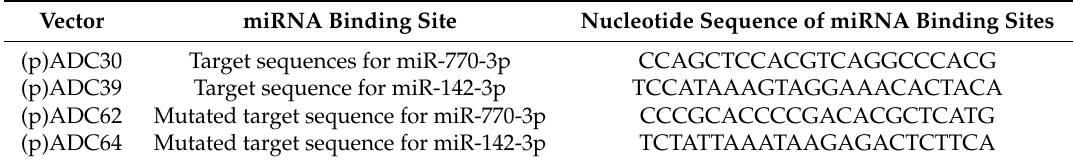
Table 2. Nucleotide sequence of miRNA binding sites incorporated in reporter vectors. Vector miRNA Binding Site Nucleotide Sequence of miRNA Binding